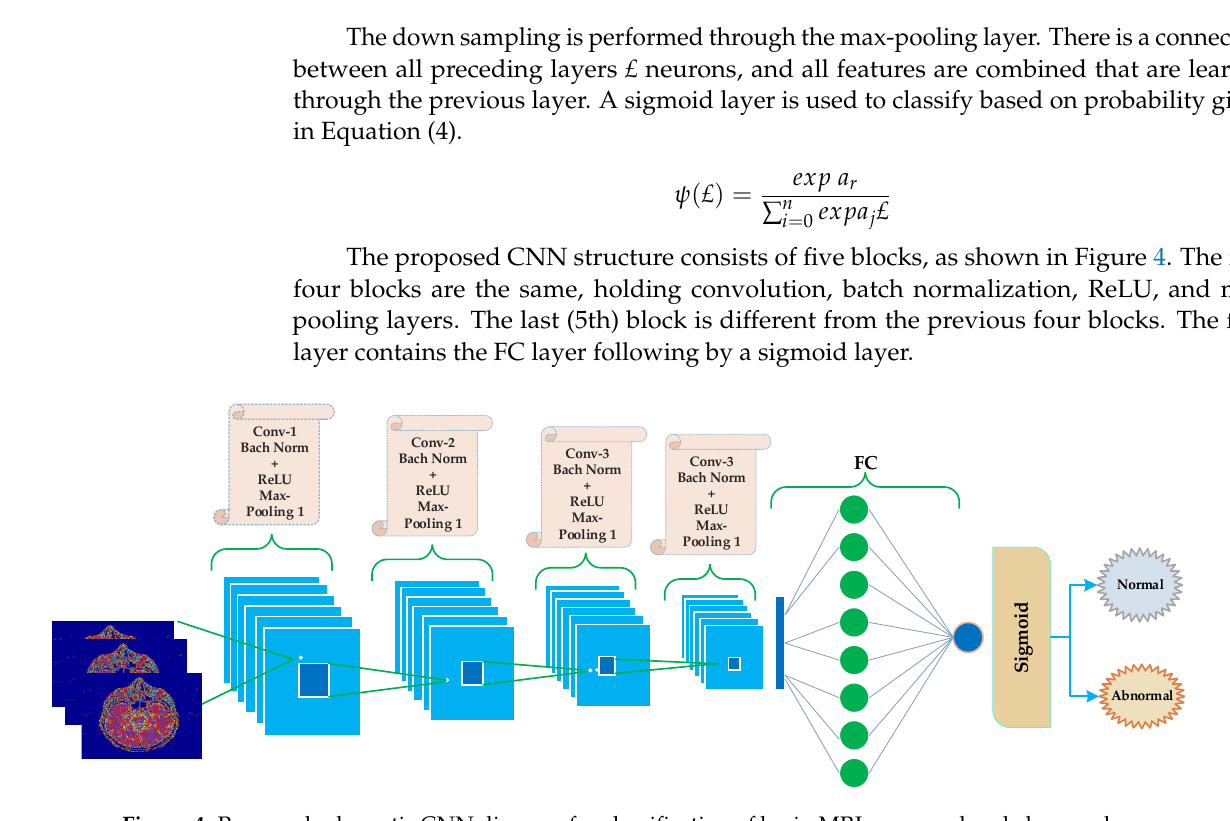
In Equation (2) the parameters 𝛾(cid:3556) and 𝛽(cid:3560) represent the offset and scale factors, respectively. The 𝛾(cid:3556) and 𝛽(cid:3560) factors are updated during the network training process. ReLU is used to perfom thresholding operations as given in Equation (3). The down sampling is performed through the max-pooling layer. There is a connection between all preceding layers £ neurons, and all features are combined that are learned through the previous layer. A sigmoid layer is used to classify based on probability given in Equation (4).